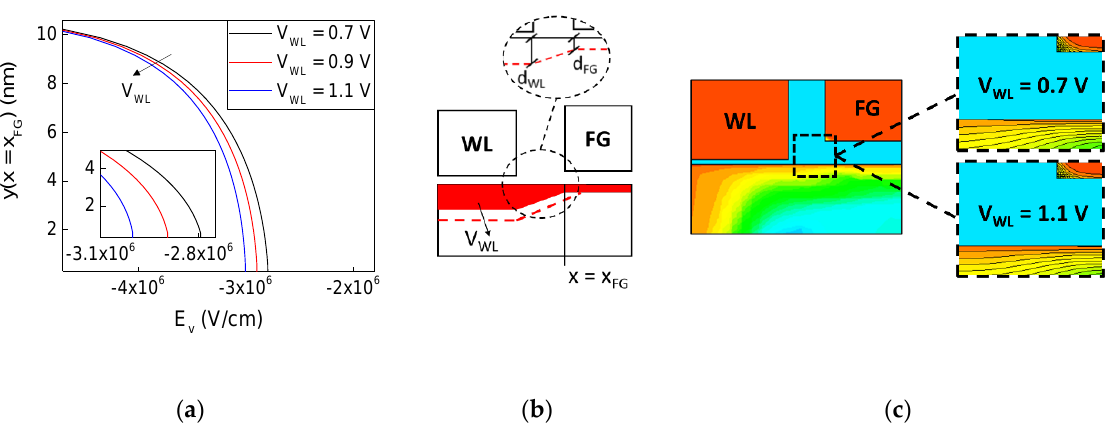
Figure 6. ( a ) TCAD simulation of the electric field vertical component drawn against the y coordinate in x = X FG , between the SiO 2 interface and the FG edge, with the WL voltage as a parameter. ( b ) The shape of the channel is depicted with colored area, while the dashed contour highlights that increasing V WL the channel invades the area beneath the FG. ( c ) TCAD simulation of the channel electron density in x = X FG represented by colors from blue to red, for two values of V WL .